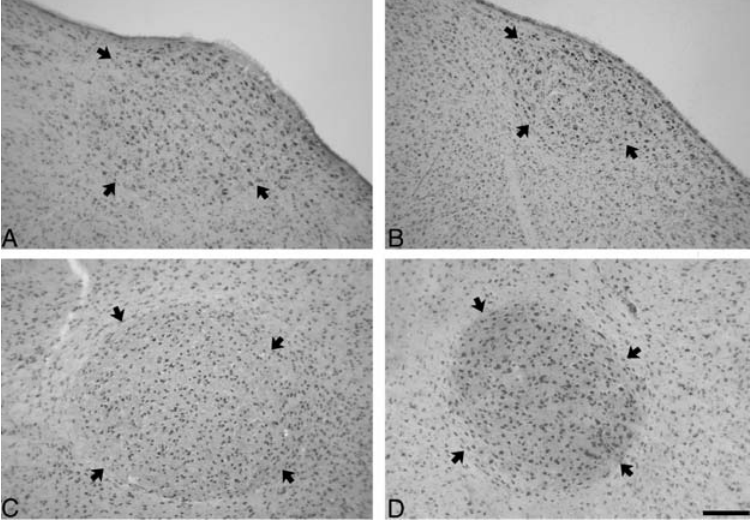
Figure 2. The volume of HVC of all males was larger compared with all females. Photomicrographs of the Nissl-stained HVC ( A, B ) and RA ( C, D ) of a male (A, C) and his female (B, D) mate (parasagittal sections). Arrows indicate the borders of HVC and RA. Scale bar is 100 m m.